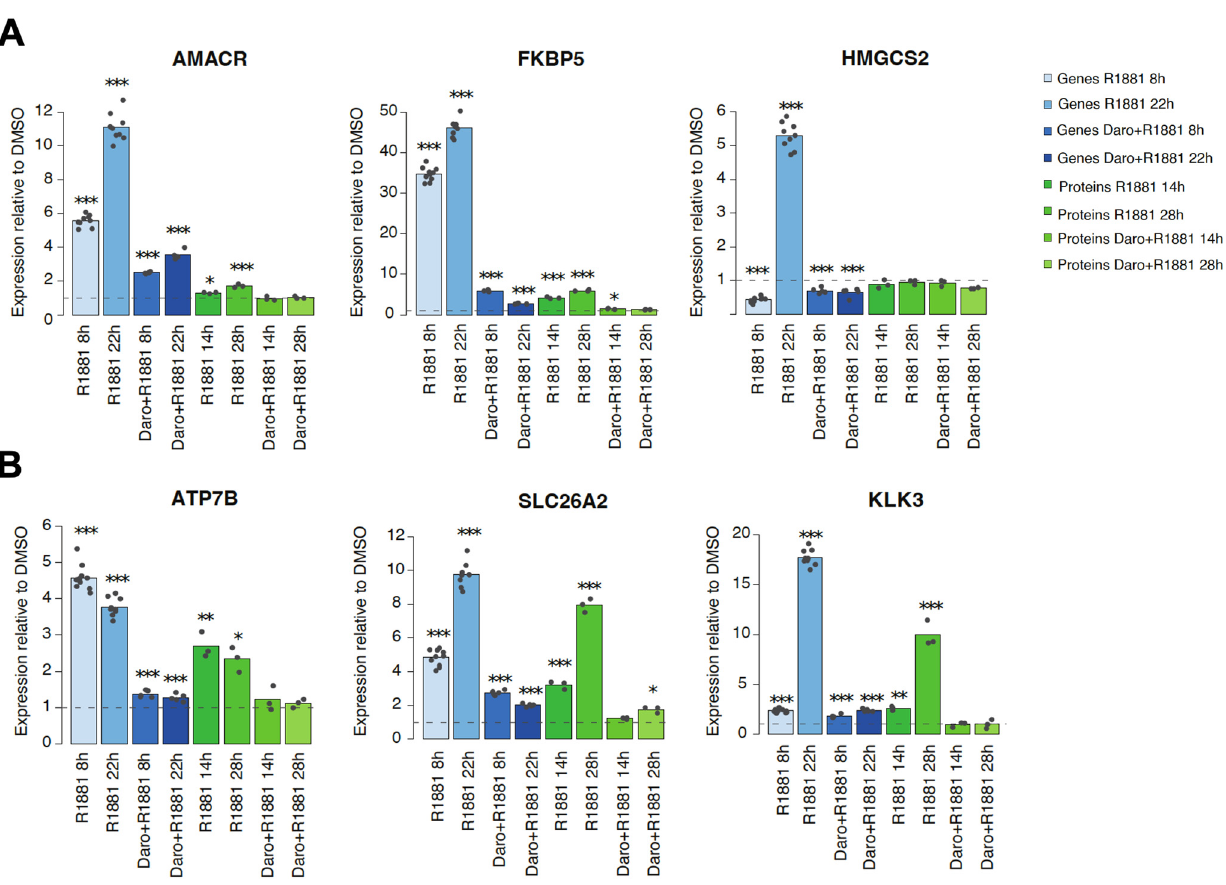
Figure 5. Gene and protein expression changes upon androgen, or androgen and darolutamide treatment, relative to the corresponding DMSO control which was set to 1 (grey horizontal dotted line). Blue bars indicate expression of genes measured by RNA-seq, green bars indicate levels of proteins measured by tandem mass spectrometry. ( A ) Examples of genes with discordant changes in mRNA and protein levels. ( B ) Examples of genes with similar responses at the mRNA and protein levels. Stars indicate the false discovery rate (FDR) for comparison of the indicated condition to the corresponding DMSO control: *** p < 0.0001, ** p < 0.001, * p < 0.01.